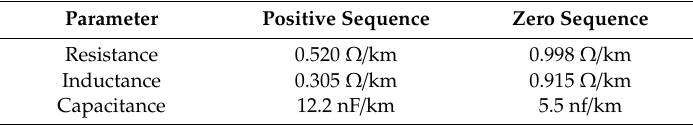
Table 2. The low voltage transmission line parameters.